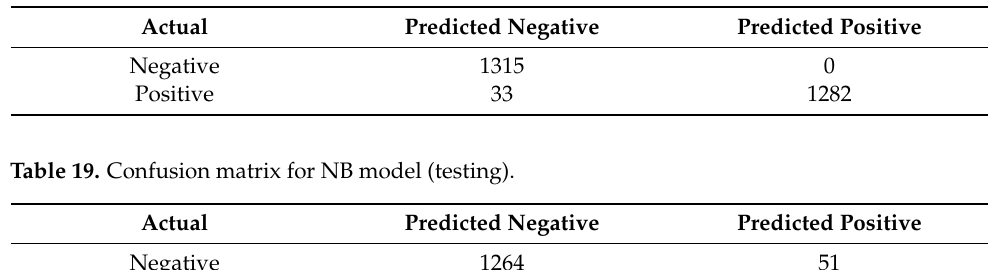
Table 18. Confusion matrix for RF, SVM, k-NN, and ANN models (testing).